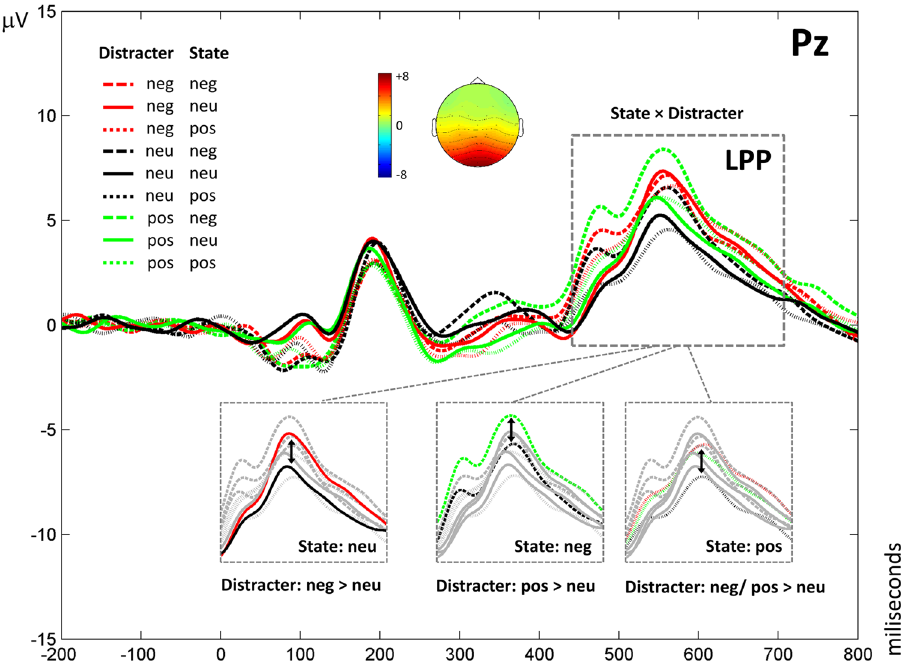
Figure 3. Results found in LPP. Grand averages are presented at Pz, where results are clearly visible. Significant interactions are shown in detail.